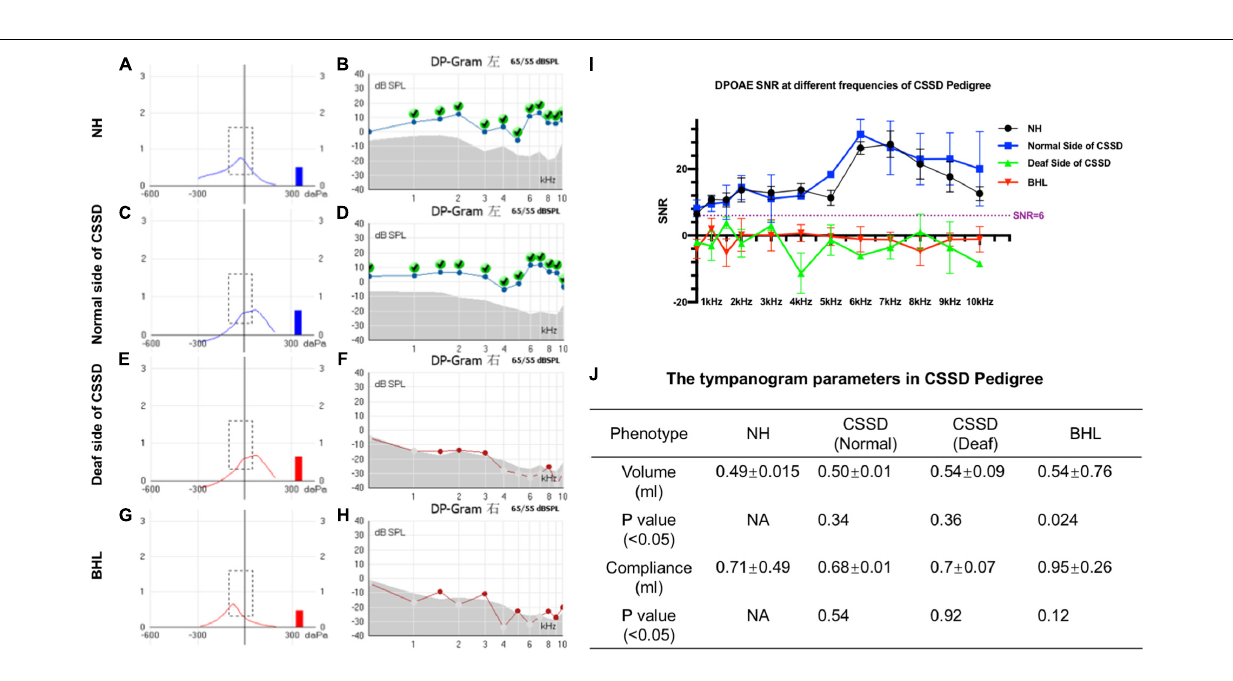
Frontiers in Cell and Developmental Biology |